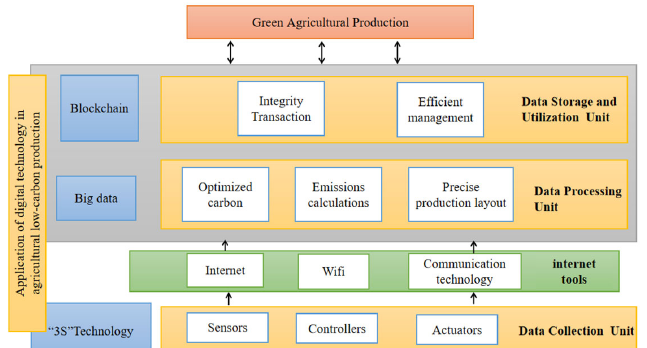
Figure 1. The general idea of digital information technology enabling the transformation of low- carbon green agriculture.